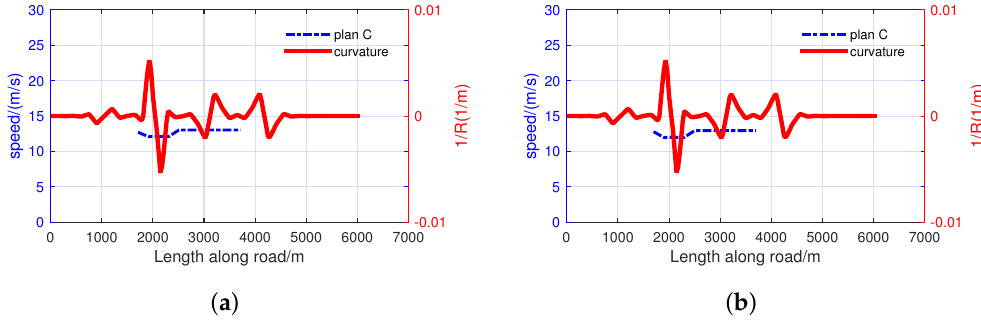
Figure 33. Speed Plan C: ( a ) Controller A + ISPFCE and ( b ) Controller B + ISPFCE.